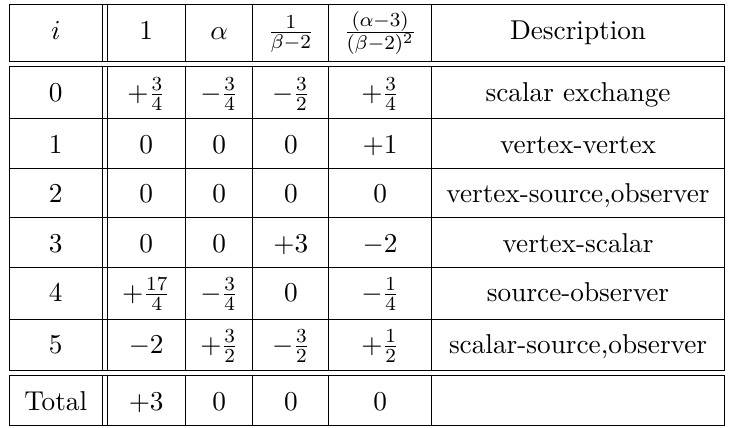
Table 1 . The gauge dependent factors C i ( α, β ) for each contribution to the invariant scalar self-mass-squared, and their gauge-independent sum. Figure 1 shows the i = 0 and i = 1 diagrams.